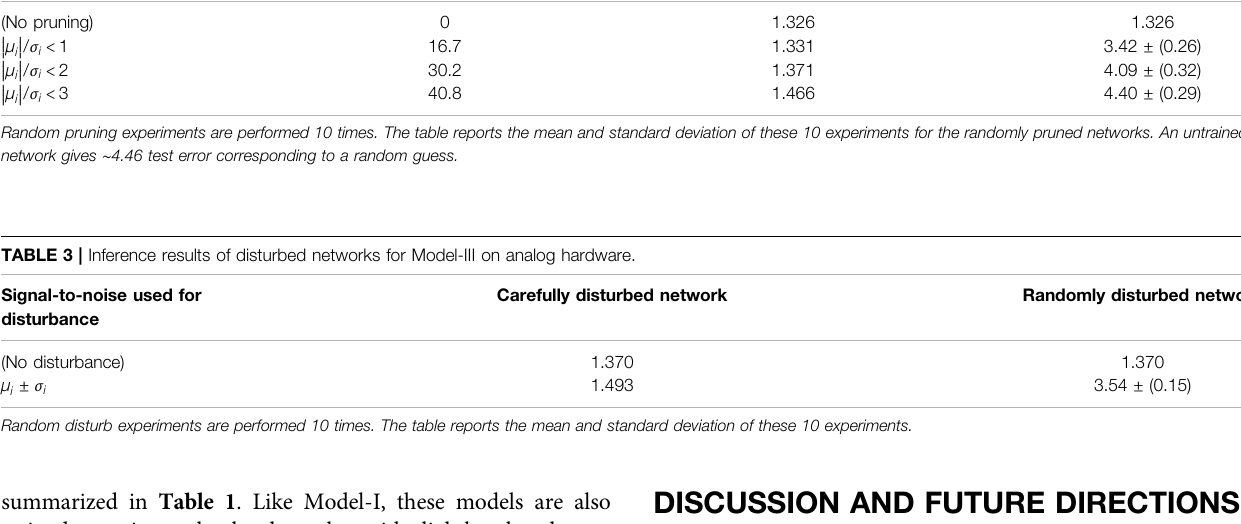
TABLE 2 | Inference results of pruned networks for Model-III on digital hardware. Signal-to-noise used for pruning